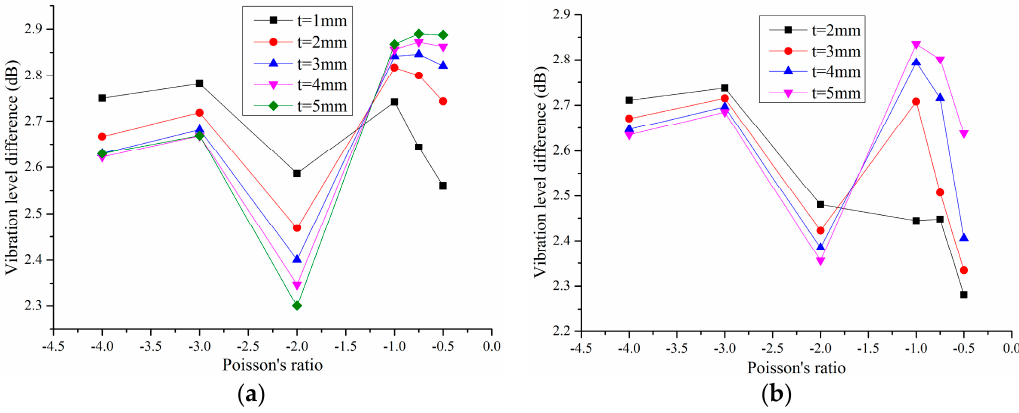
Figure 9. Acceleration vibration level difference of the center cell against the Poisson’s ratio for different scales: ( a ) initial models; ( b ) scale-up models.